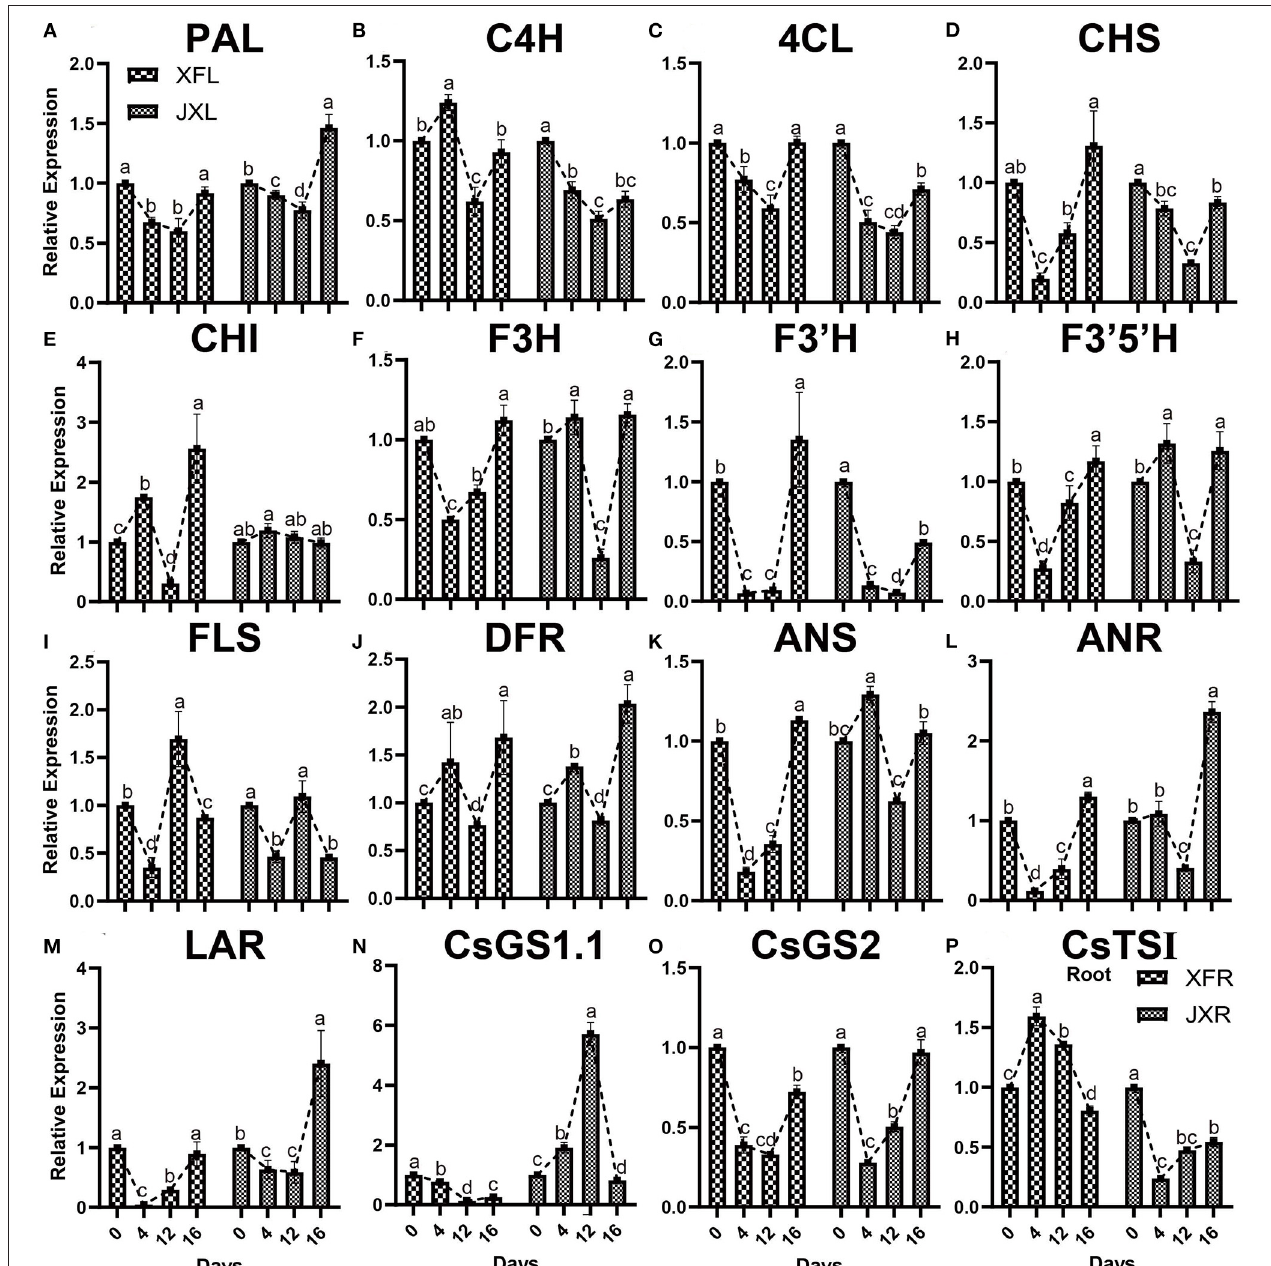
FIGURE 6 | Expression of a selected set of genes in the leaves and roots of two cultivars (“Xiangfeicui” and “Jinxuan”) exposed to different shading treatments. The expression of each gene was calculated relative to GAPDH gene. (A) PAL , phenylalanine ammonia lyase; (B) C4H , cinnamate 4-hydroxylase; (C) 4CL , 4-coumarate–CoA ligase; (D) CHS , chalcone synthase; (E) CHI , chalcone isomerase; (F) F3H , flavanone 3-hydroxylase; (G) F3 ′ H , flavonoid 3 ′ -monooxygenase; (H) F3 ′ 5 ′ H , flavonoid 3 ′ ,5 ′ -hydroxylase; (I) FLS , flavonol synthase; (J) DFR , dihydroflavonol-4-reductase; (K) ANS , anthocyanidin synthase; (L) ANR , anthocyanidin reductase; (M) LAR , leucoanthocyanidin reductase; (N) CsGS1.1 , glutamine synthetase 1.1; (O) CsGS2 , glutamine synthetase 2; (P) CsTSI, theanine synthetase I (in root). Data were assessed by one-way ANOVA followed by Duncan’s multiple range test. XFL, the leaf of “Xiangfeicui” cultivar; JXL, the leaf of “Jinxuan” cultivar; XFR, the root of “Xiangfeicui” cultivar; JXR, the root of “Jinxuan” cultivar.